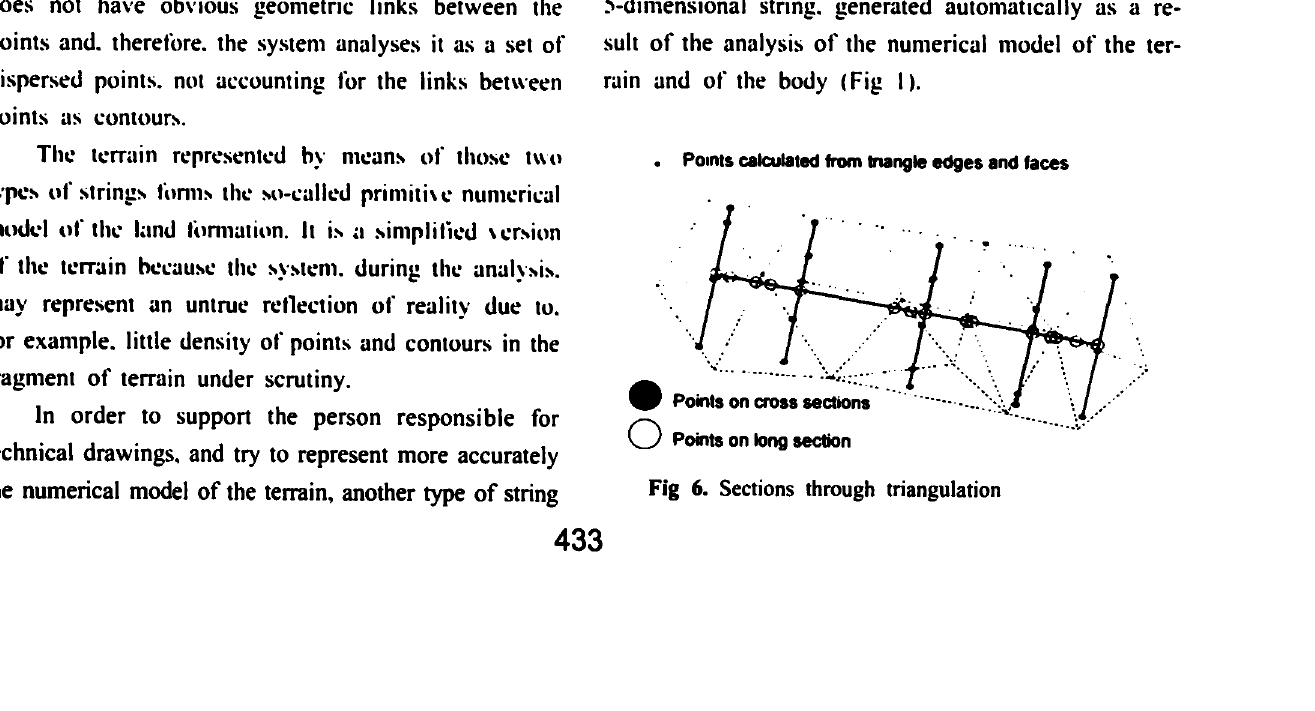
Fig 6. Sections through